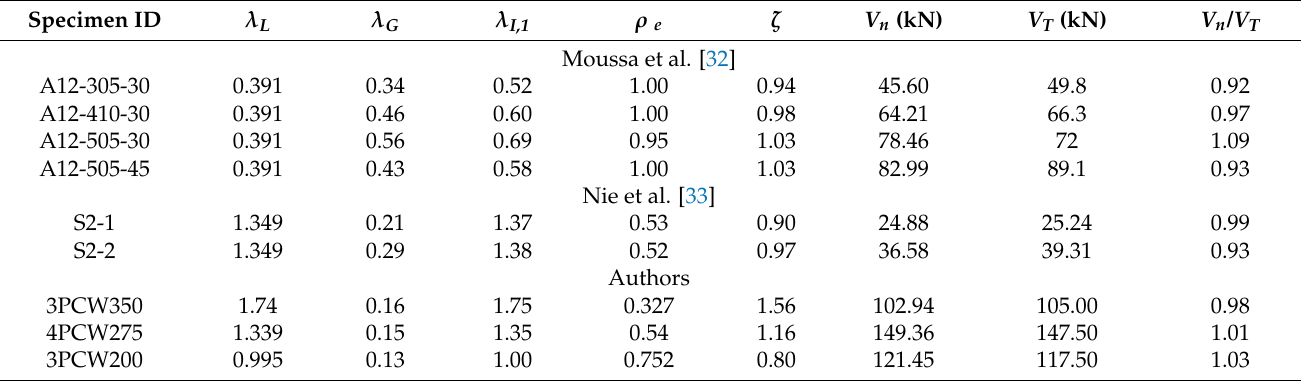
Table 6. Analysis results of test specimens reported in previous